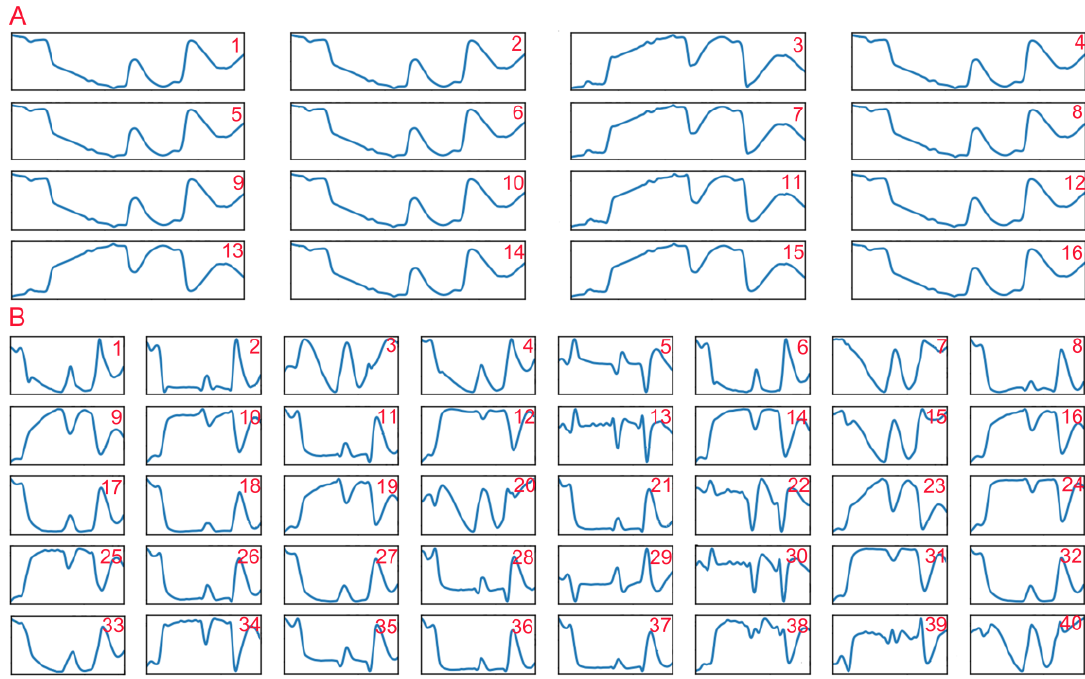
Figure 7. The partial convolution results of the first convolutional layer ( A ) and the second convolutional layer ( B ) in the one-dimensional convolutional neural network (1DCNN) model.